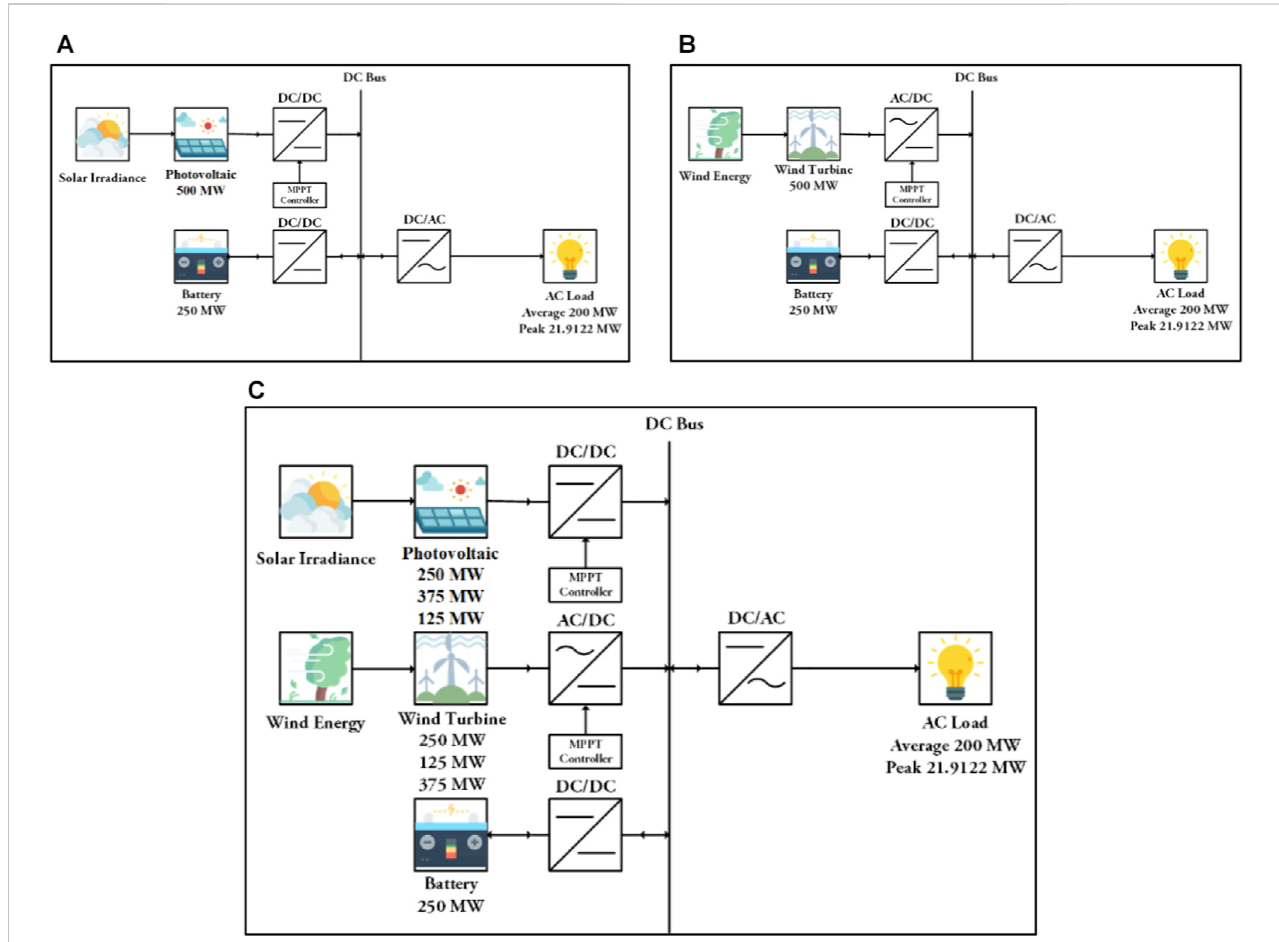
FIGURE 5 Standalone (off-grid) hybrid renewable system with an ESS. (A) PV and battery off-grid connected; (B) wind turbine and battery off-grid connected; (C) PV, wind turbine, and battery off-grid connected with PVs and wind turbines of three different capacities.